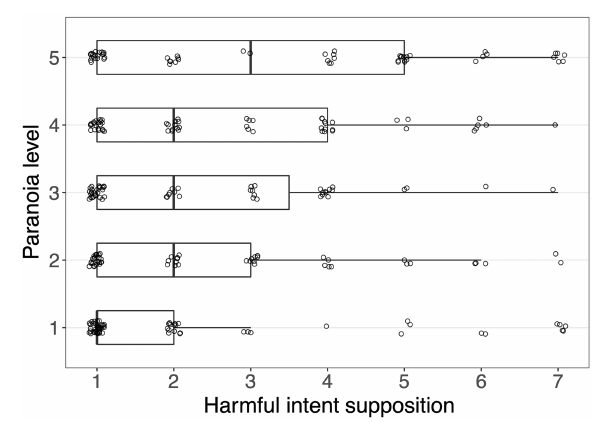
FIGURE 1 | Distributions of presumptions about the opponent’s harmful intent according to paranoia levels. For visualization, paranoia scores were categorized into five levels in terms of quantiles (1, 32–34; 2, 35–39; 3, 40–50; 4, 51–72; and 5, 73–160). Each point represents each participant. Boxplots indicate the distributions of the paranoia score. The box, the thick line in each box, and the whisker represent the interquartile range (IQR), the median, and the distances 1.5 × IQR, respectively. Random jitter was added to each point for ease of